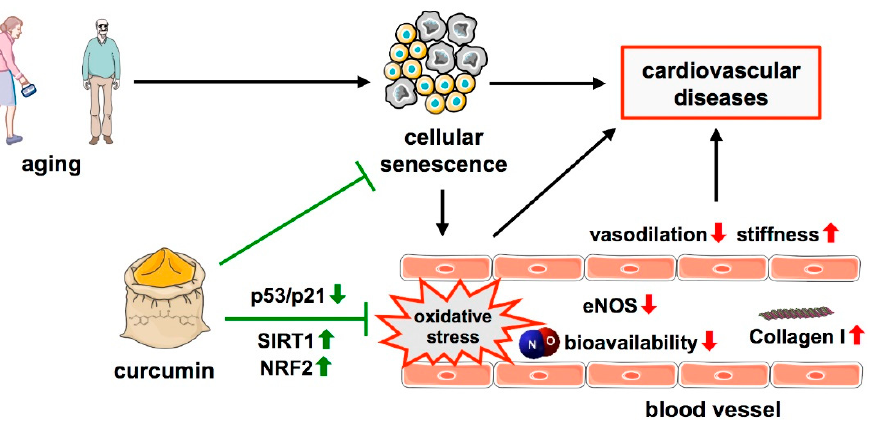
Figure 1. Protective effects of curcumin in age-related cellular senescence. A hallmark of aging, one major risk factor for cardiovascular diseases is cellular senescence which is associated with oxidative stress in blood vessels, along with decreased levels of eNOS, NO bioavailability, reduced vasodilation, and increased vascular stiffness due to increased Collagen I levels. Curcumin antagonizes these effects by the upregulation of SIRT1 and NRF2 and downregulation of the p53/p21 pathway. —increased; —decreased.